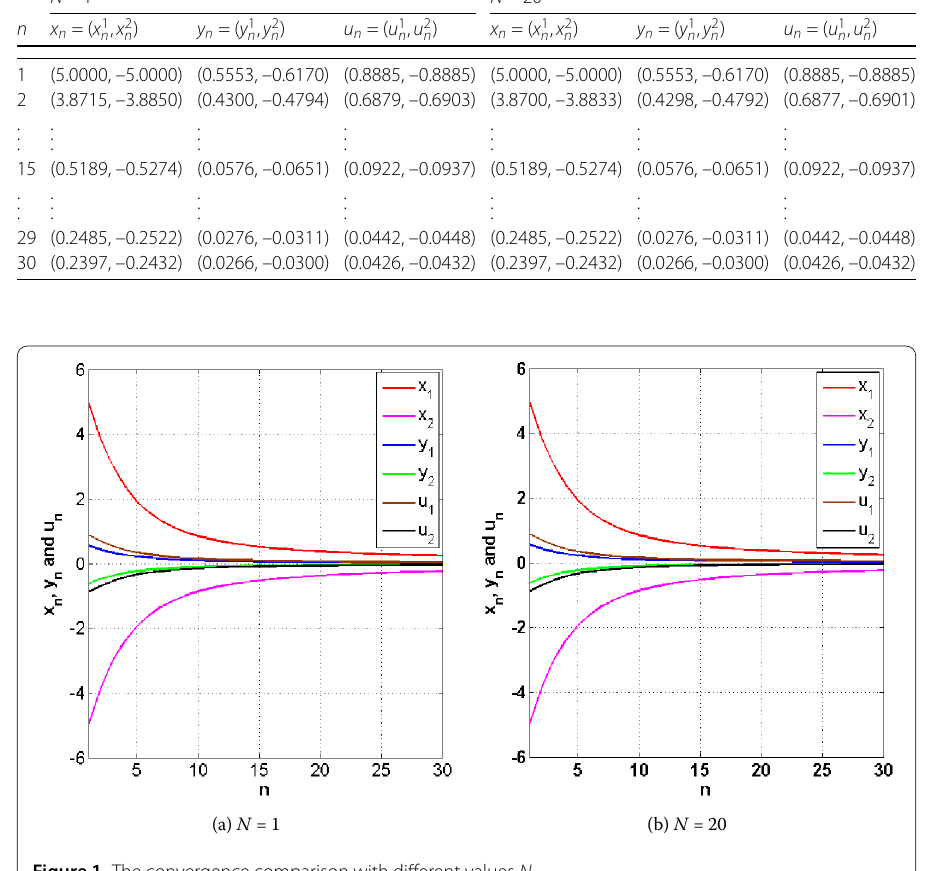
Table 1 The values of { x n } , { y n } and { u n } where u = (5,–5), x 1 = (5,–5) and n = 30 N = 1 N = 20 n x n = ( x 1 n , x 2 n )